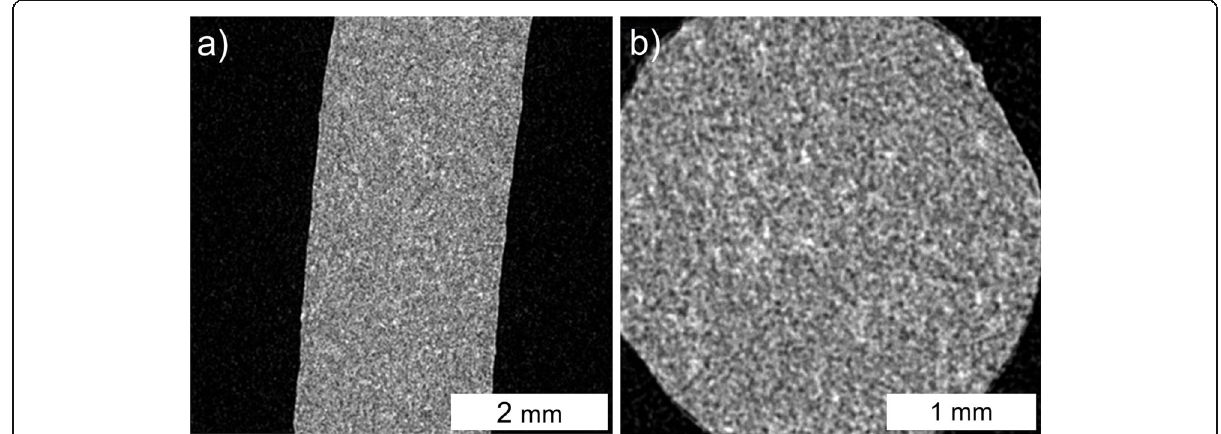
Fig. 3 μ -CT scan of AC50% filament prior to printing: General overview of the filament form sample a and section through X-Y plane b Y-Z